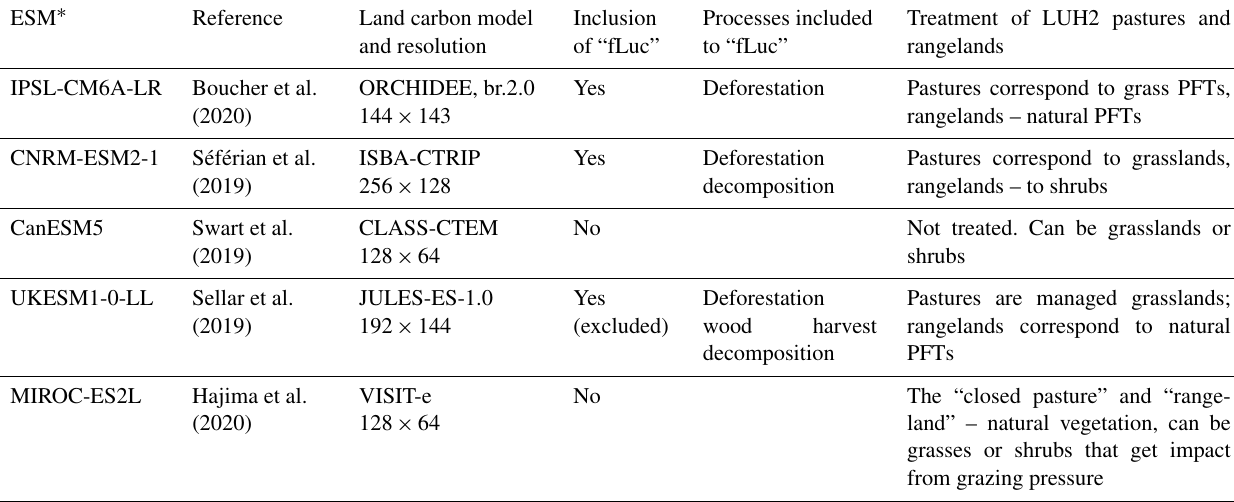
Table 1. Major characteristics of the Earth system models. ESM ∗ Reference Land carbon model IPSL-CM6A-LR ORCHIDEE, br.2.0 Deforestation Pastures correspond to grass PFTs,